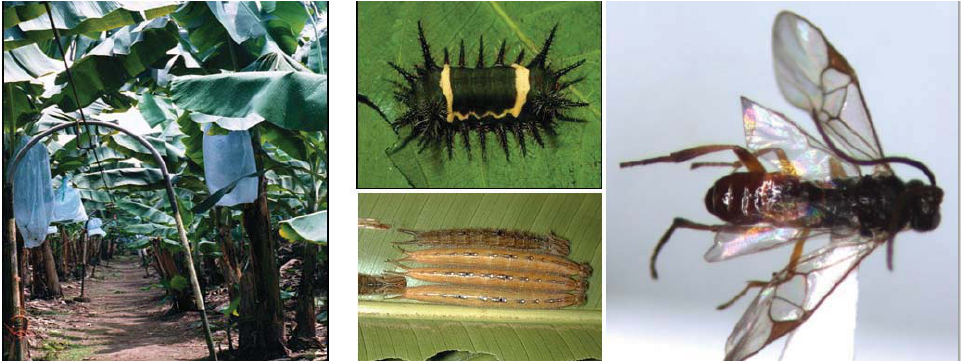
Figure 1. A subsample of our model study organisms. Clockwise from left: banana plants with fruit bags that contain chlorpyrifos; Acharia nesea (Limacodidae) larva; Cotesia sp. (Braconidae) adult parasitoid; Caligo memnon (Nymphalidae)